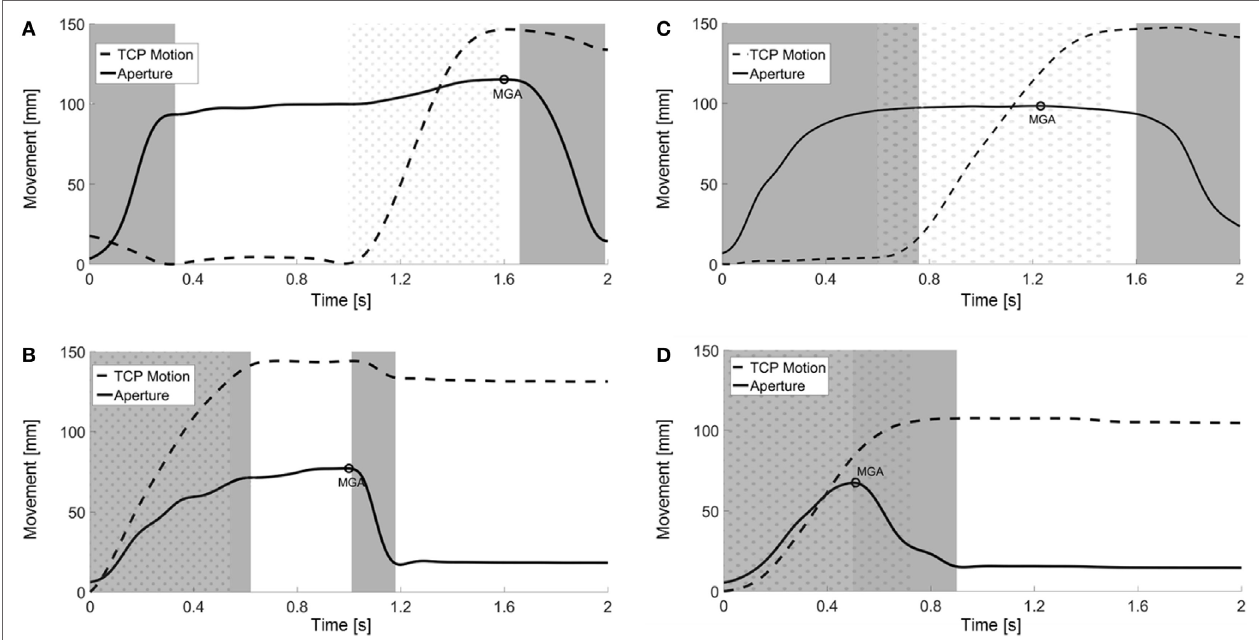
FigUre 4 | Grasp demonstration: representative motion profiles for tool center point motion (TCP) toward the object (dotted line) and for the grip aperture (full line). (a) Alongside, object L (Subject 1). (B) Across, object XL (Subject 2). (c) Across, object M (Subject 3). (D) Alongside, object L (Subject 4). Gray background marks aperture opening and closing epochs. Dotted background marks TCP motion